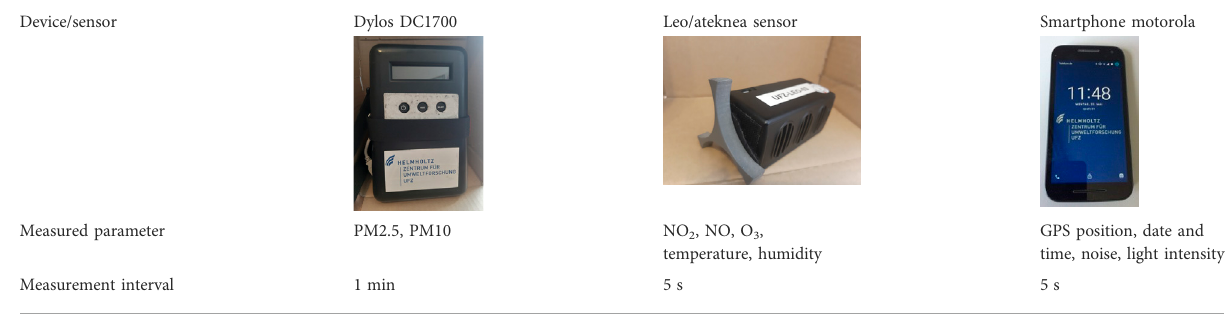
TABLE 1 Sensor set for the measurement campaign 2020.